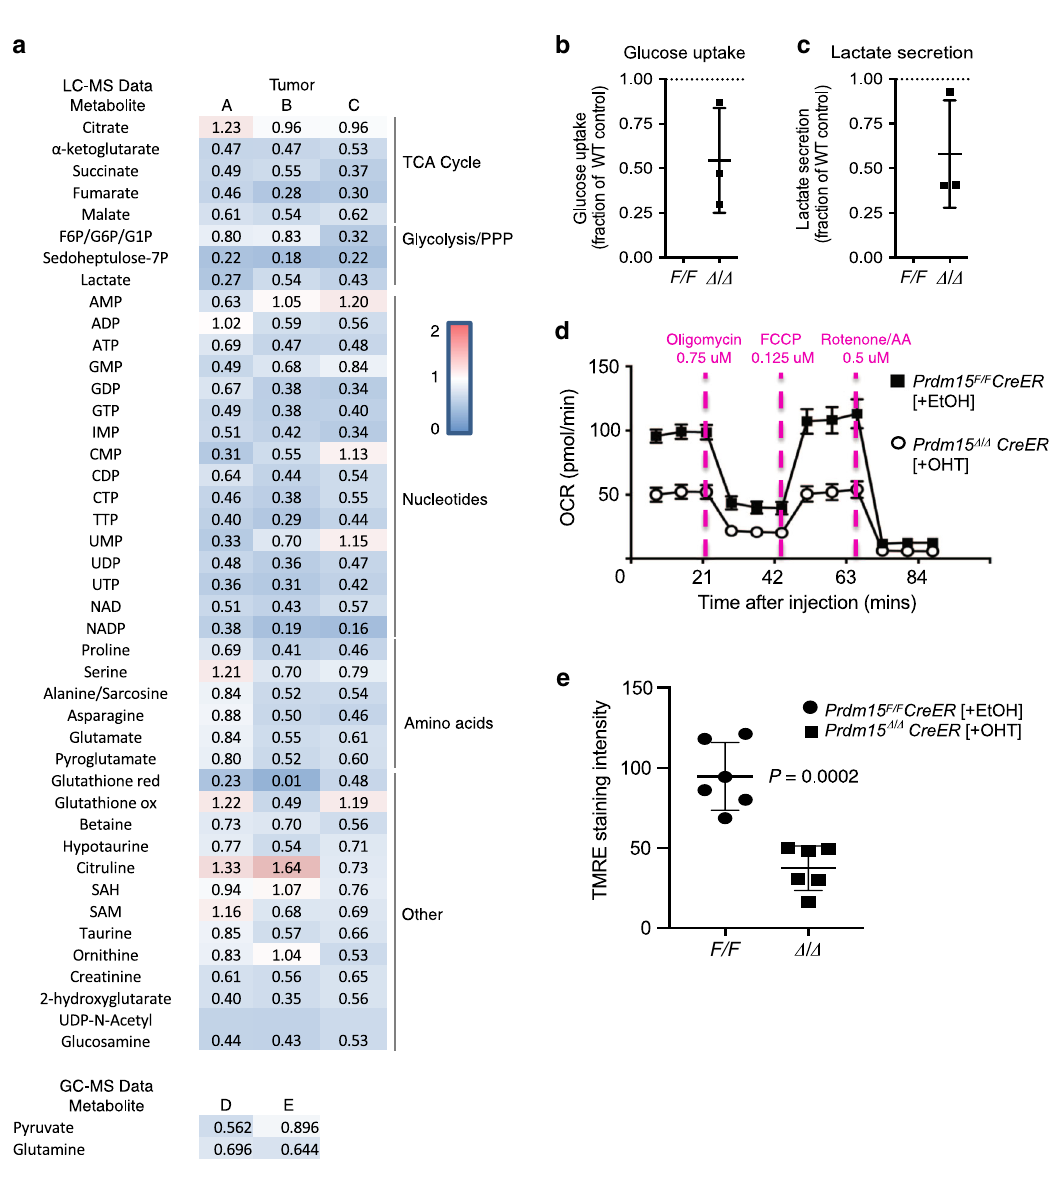
Fig. 6 PRDM15 transcriptionally rewires B cell metabolism. a Top: Summary of the LC/MS metabolomics analysis in Prdm15 F/F vs. Prdm15 Δ / Δ E µ -Myc cells. TCA cycle, glycolysis/pentose phosphate pathway (PPP), nucleotides, amino acids, and other metabolites. Indicated values correspond to the average level of each metabolite in E µ -Myc ; Prdm15 Δ / Δ cells relative to the E µ -Myc ; Prdm15 F/F control cells. Data were collected from three independent tumors (A, B and C), each consisting of three technical replicates. Bottom : Summary of the GC/MS metabolite analysis. Pyruvate and Glutamate levels were measured in two independent tumors. The average is shown for tumors D and E. Data represents three biological replicates, each performed in technical triplicates. b and c One day post PRDM15 KO-induction, Prdm15 F/F (WT) and Prdm15 Δ / Δ cells were seeded in fresh media. 24 h later, glucose and lactate concentration in the cellular media were measured and subtracted from that of media alone. b Glucose uptake and c lactate secretion are shown relative to the Prdm15 F/F (WT) cells. Error bars represent SD ( n = 3 primary lines). d Seahorse Mito Stress Test Assay. Prdm15 F/F ;CreER;E µ -Myc tumor cells were treated with either EtOH (control) or OHT (to induce PRDM15 depletion). Cells were then seeded onto 96-well Seahorse assay plates to measure cellular respiration. Compounds were loaded into a hydrated cartridge in the following order: Port A 25 µ l Medium, Port B 0.75 µ M Oligomycin, Port C 0.125 µ M FCCP, and Port D 0.5 µ M Rotenone/AntimycinA. e TMRE staining. Prdm15 F/F ;CreER;E µ -Myc tumor cells were treated with either EtOH (control) or OHT (to induce PRDM15 depletion) and stained with TMRE at concentration of 200 nM for 30 min before washing off. Data are from independent primary lines ( n = 6). Center values mean; error bars, s.d. Cells were imaged and quanti fi ed using ImageJ analysis software ( n = 3 images/sample analyzed). Student ’ s t test (two-sided) was used for statistical decrease in citric acid cycle (CAC) intermediates including nucleotides. Accordingly, and in keeping with the downregulation α -ketoglutarate, malate, succinate, and fumarate, as well as a of genes playing a role in purine and pyrimidine synthesis ( Tk1 ), number of amino acids including asparagine, glutamate, and levels of IMP and NTPs were lower in cells devoid of PRDM15 proline (Fig. 6a). Intriguingly, levels of citrate, serine, and some relative to controls (Fig. 6a). Loss of PRDM15 also resulted in